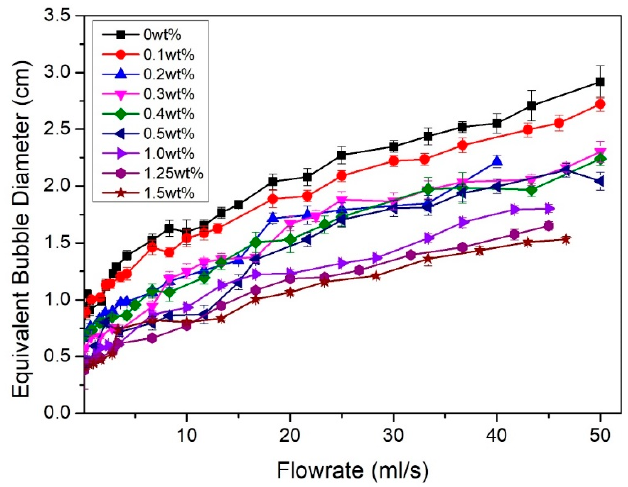
Figure 6. Equivalent bubble diameter of bubbles produced at different PEBAX concentration under different air flow rates.